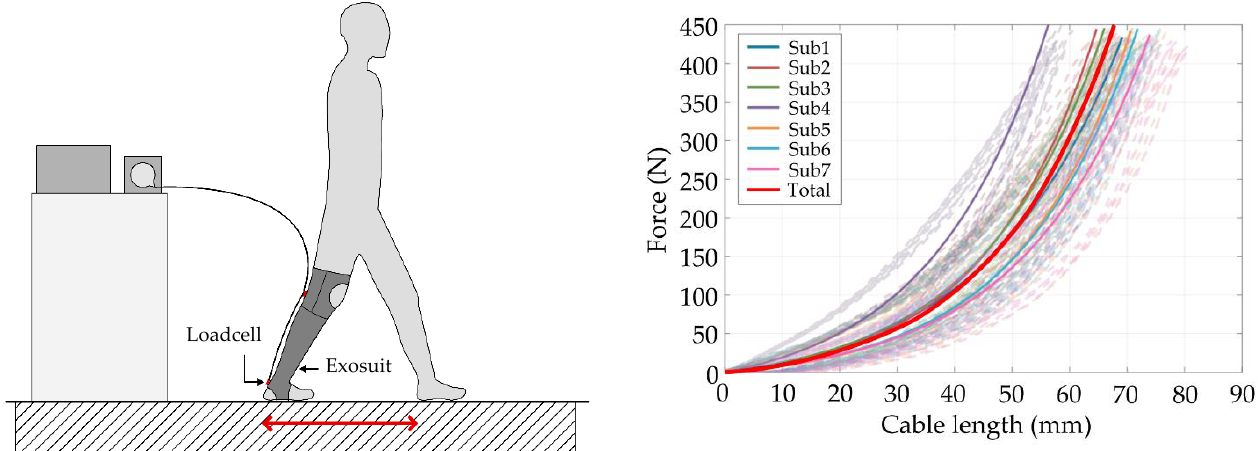
Figure 9. As an ankle exosuit, the most important function of kneE-XOcks is its ability to transmit power to the body. A stiffness test in a static posture shows that kneE-XOcks can transmit force to the body without significant deformation.